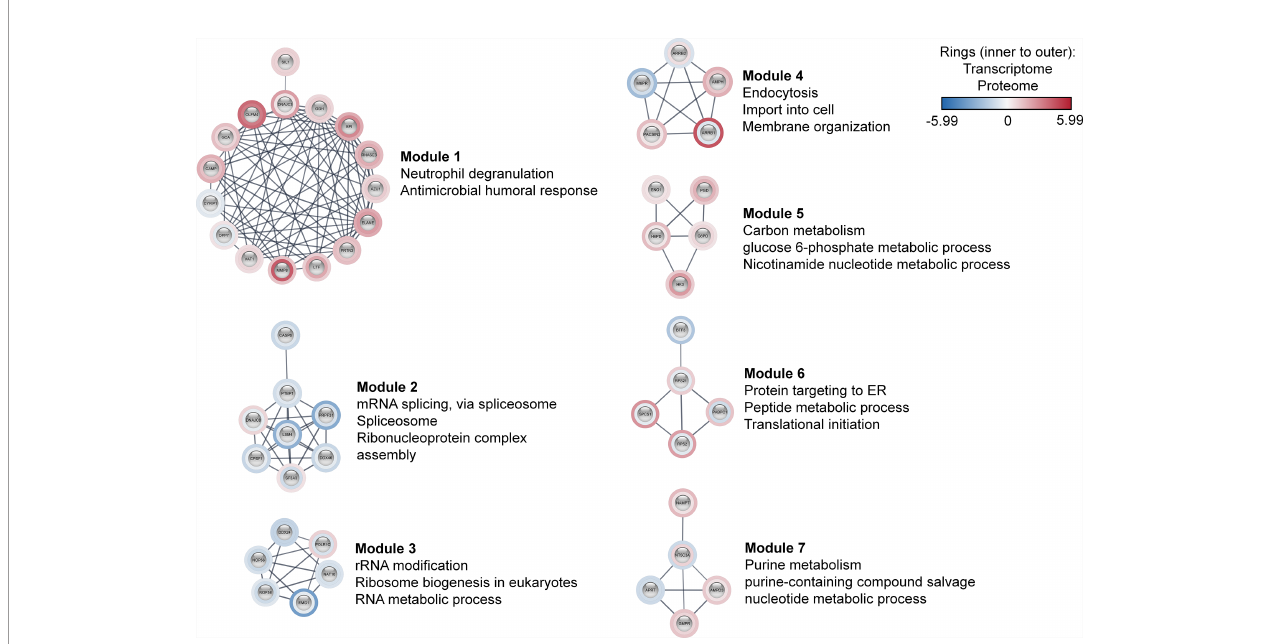
FIGURE 3 | Co-differentially expressed modules in clinical sepsis. Blue nodes represent the down-regulated nodes, and the red nodes represent the up-regulated nodes. Inner rings represent transcriptome data, outer rings represent the proteome data. The modules and their top enriched pathways (FDR-corrected p -value <0.05) generated through the STRING enrichment are shown separately.